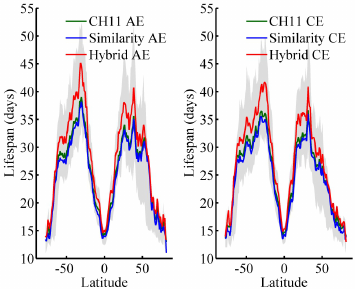
Figure 13. Meridional profiles of the average (solid lines) eddy lifespans (in days) as tracked by the three methods and the interquartile range of the distribution from the hybrid method (grey shading) in 1 ◦ latitude bands.